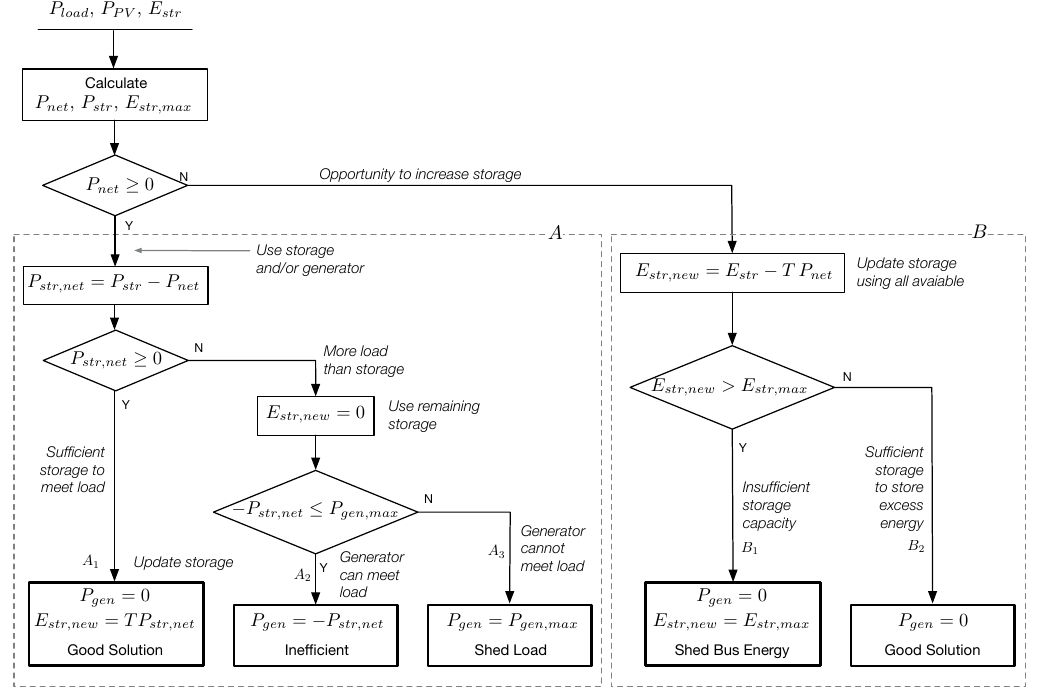
Figure 1. Flowchart of the rule-based EMS. The pathway blocks labeled A and B correspond to PV availability. Block A paths are used when there is not enough PV to meet the loads while the block B paths are used when there is enough PV to meet the loads and there is an opportunity to store excess